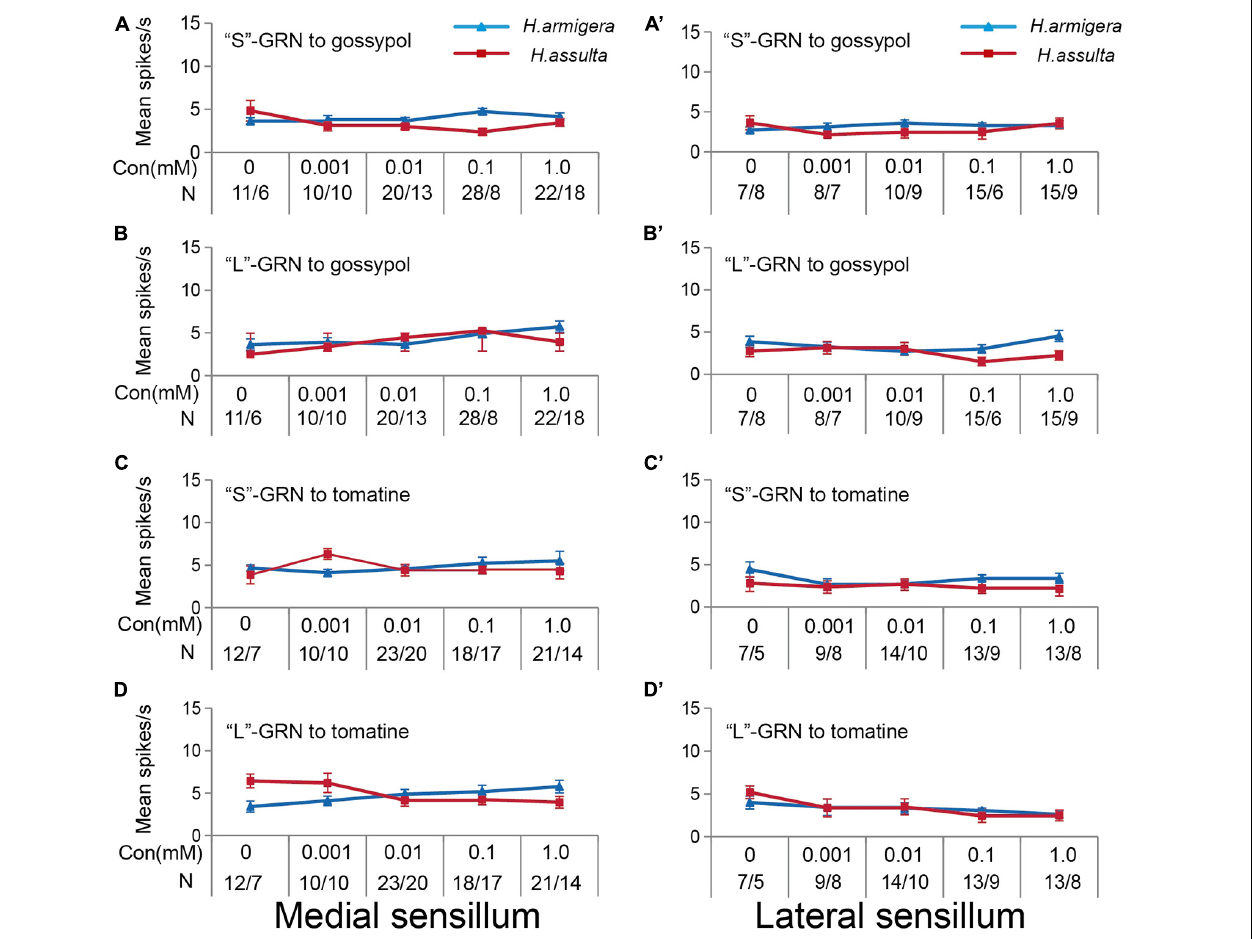
FIGURE 8 | Responses of “S” and “L” GRNs in the styloconic sensilla of Helicoverpa caterpillars to gossypol and tomatine. (A,A’) : responses to gossypol of the indentified “S” GRNs from the medial and the lateral sensillum, respectively; (B,B’) : responses to gossypol of the indentified “L” GRNs from the medial and the lateral sensillum, respectively; (C,C’) : responses to tomatine of the indentified “S” GRNs from the medial and the lateral sensillum, respectively; (D,D’) : responses to tomatine of the indentified “L” GRNs from the medial and the lateral sensillum, respectively.